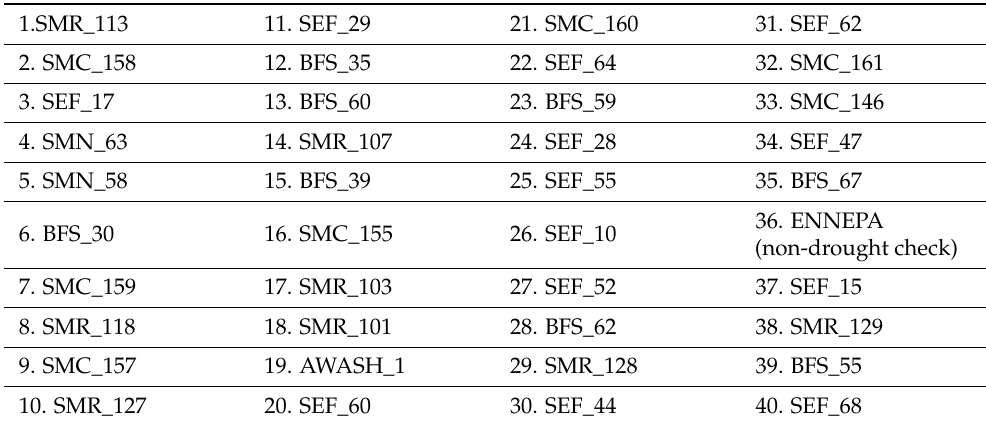
Table 16. List of selected best 40 performing drought-tolerant common bean lines used in screen- house experiment.